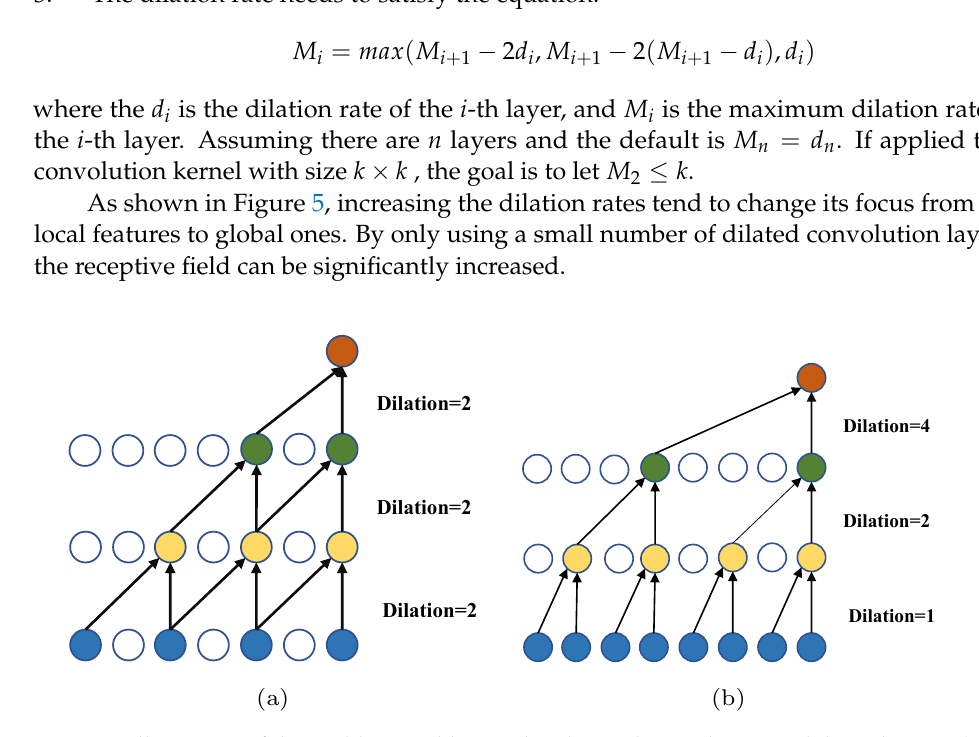
Figure 6. Components of temporal